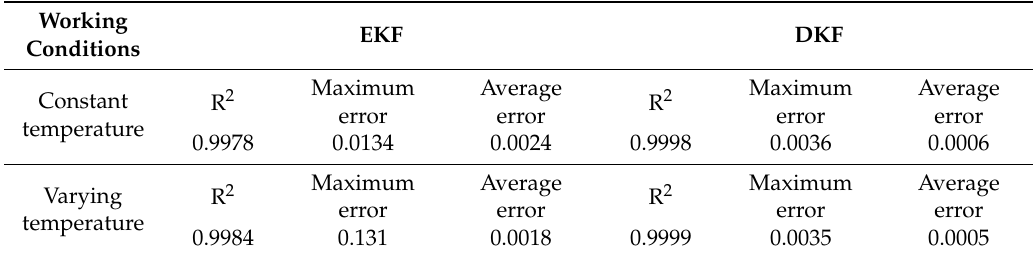
Figure 12. Algorithm verification results for the DST: ( a ) estimated SOC values and estimation error under constant temperature condition, the magnified mini-plot is an enlarged view for the time range of 550 s–900 s; and ( b ) estimated SOC values and estimation error under varying temperature condition. The magnified mini-plot is an enlarged view for the time range of 550 s–900 s. Table 5. Accuracy comparison between extended Kalman filter (EKF) and dual Kalman filter (DKF) under different working conditions.